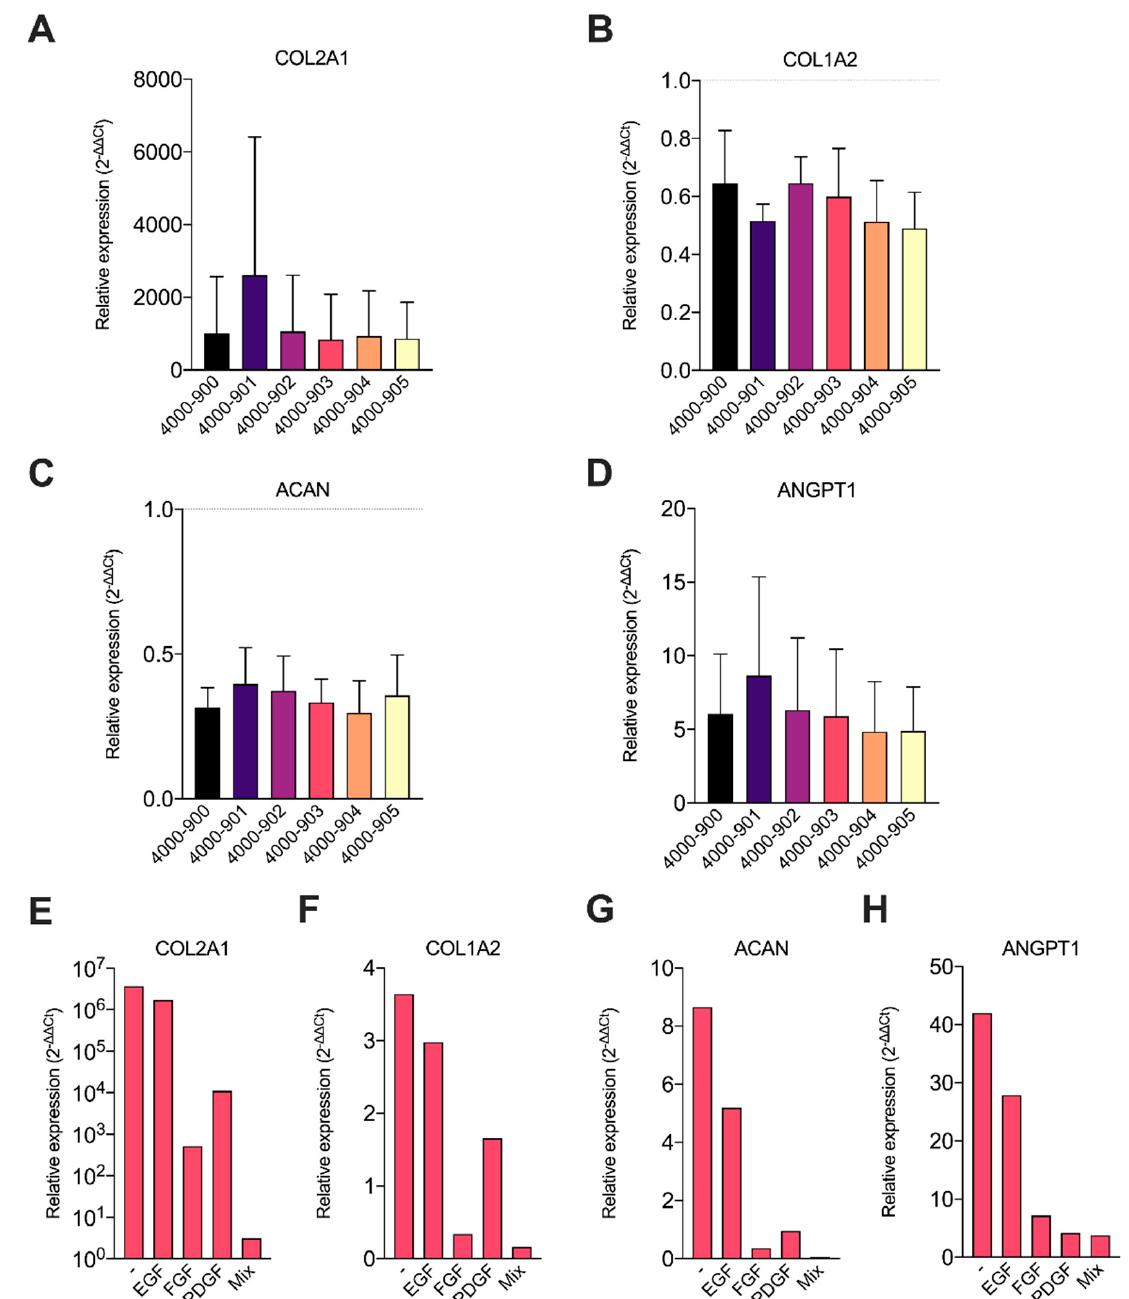
Figure 3. Relative gene expression levels of ( A ) COL2A1, ( B ) COL1A2, ( C ) ACAN, and ( D ) ANGPT1 for nucleus pulposus cell spheroid colonies cultured on different EZSPHERE ® dish types. ( n = 4) Relative gene expression of ( E ) COL2A1, ( F ) COL1A2, ( G ) ACAN, and ( H ) ANGPT1 of nucleus pulposus cell cultured on EZSPHERE ® dish 4000-903 ( n = 1) without (-) or with 100 ng/mL epidermal growth factor (EGF), 10 ng/mL fibroblast growth factor (FGF), 100 ng/mL platelet derived growth factor (PDGF), or a combination of all three growth factors (Mix). Data is calculated relative to monolayer cultured nucleus pulposus cells. Values derived using 2 − ∆∆ Ct method and presented as mean values with error bars presenting standard deviation.